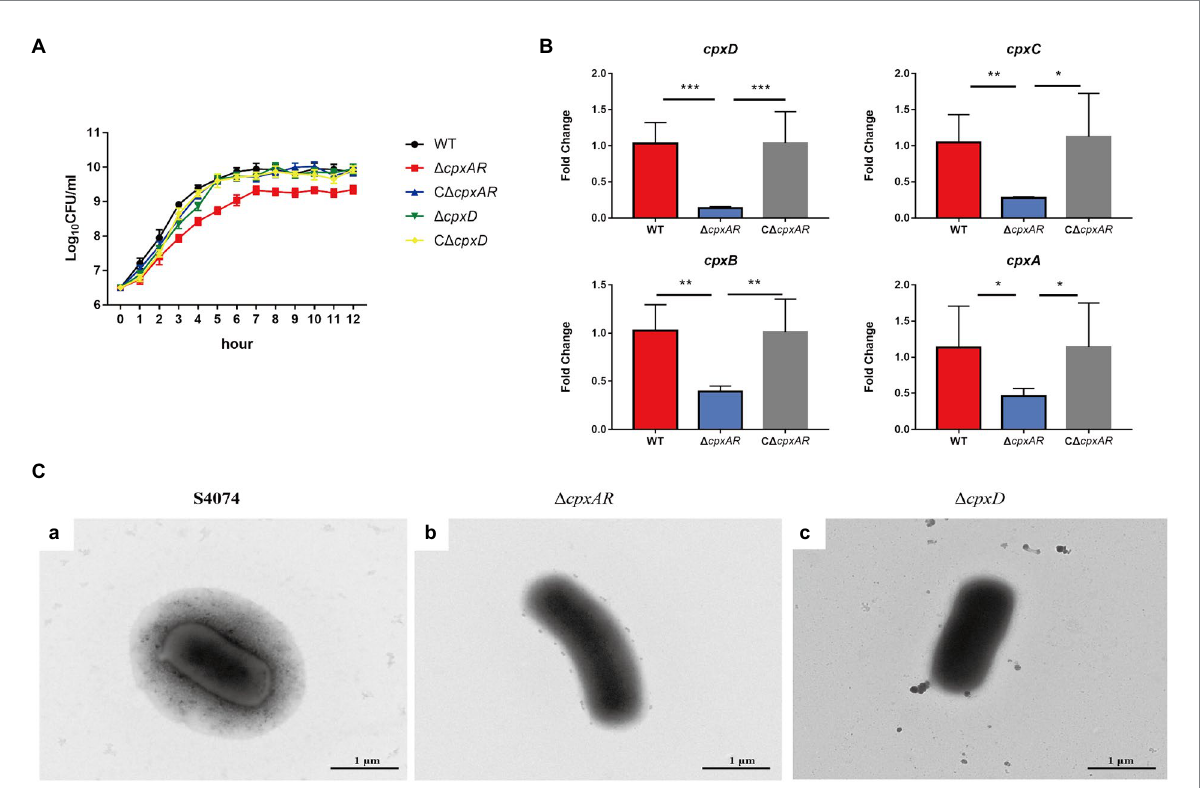
FIGURE 1 CpxAR impacts the capsule production. (A) The growth analysis of the WT S4074, ∆ cpxAR , C ∆ cpxAR , ∆ cpxD , and C ∆ cpxD strains. (B) The relative mRNA levels of cpxD, cpxC, cpxB, and cpxA (capsular polysaccharide export gene) in the Δ cpxAR mutant compared to the parent strain determined by RT-qPCR. * p < 0.05, ** p < 0.01, *** p < 0.001. (C) Observation of the capsule layer of the WT S4074 (A) , ∆ cpxAR (B) , ∆ cpxD (C) , strains by